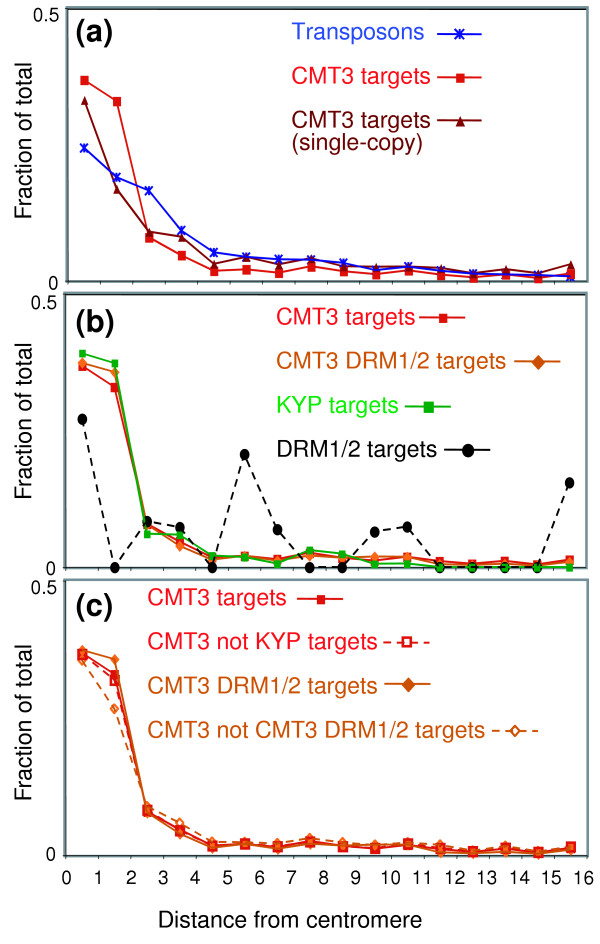
Location of transposable elements, CMT3, KYP and DRM1/2 targets along chromosome arms. (a) Transposable elements and CMT3 targets. (b) Comparison of KYP, DRM1/2 and CMT3 DRM1/2 targets to CMT3 targets. (c) Comparison of all CMT3 targets to the subset of CMT3 targets that are not also KYP targets, and comparison of CMT3 targets to the subset that are not also CMT3 DRM1/2 targets. To map repeats relative to the centromere, Repbase library sequences were searched using BLASTN with default Repbase parameters against TIGR Release 5 of the Arabidopsis genome sequence. All CMT3 targets, single-copy CMT3 targets and DRM1/2 targets from the gene-oligo array (Figure 2b) were also mapped on the same scale. The fraction of the total number of hits within each 1 Mb bin is shown. To compensate for differences in oligo abundance on the array, bins were normalized by dividing each raw fraction by the fraction of oligos in the bin.